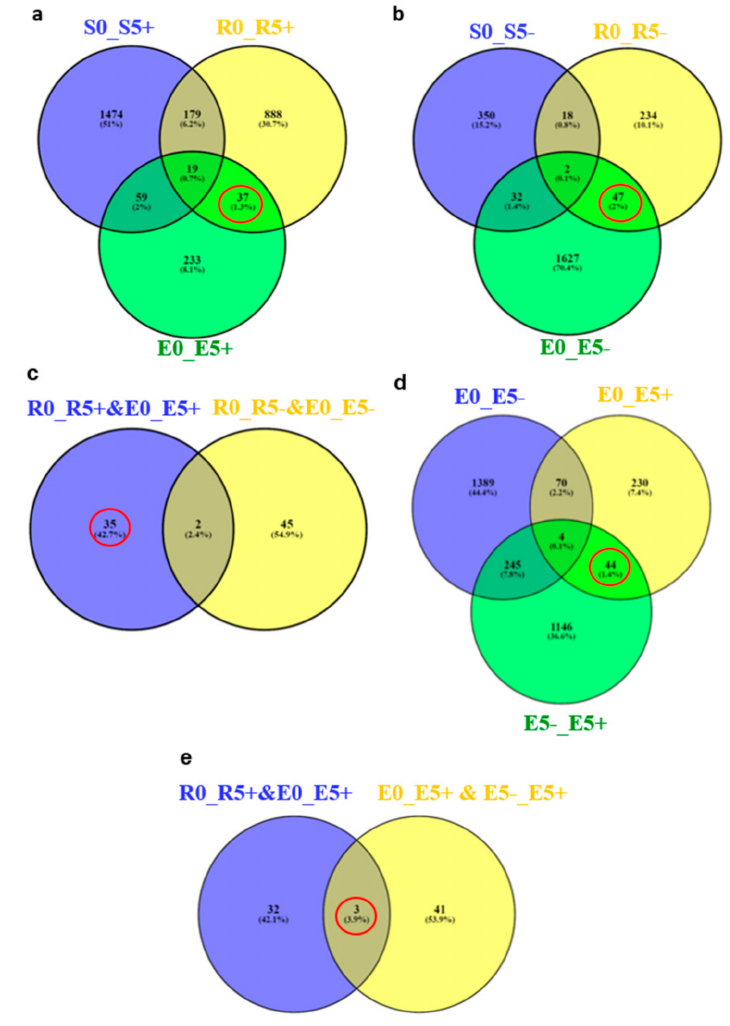
Figure 5. Venn diagram of the DEGs between the R bulk (R), S bulk (S), and EMEK3 (E) pre-infestation (0), five d post-infestation with O. cumana (5+) ( a ) and five d post-infestation without O. cumana (5 − ) ( b ). ( c ) Venn diagram of the communal DEGs of ( a , b ). ( d ) The DEG in EMEK3 pre- and five d post-infestation with or without O. cumana . ( e ) Venn diagram of the communal DEGs of ( c , d